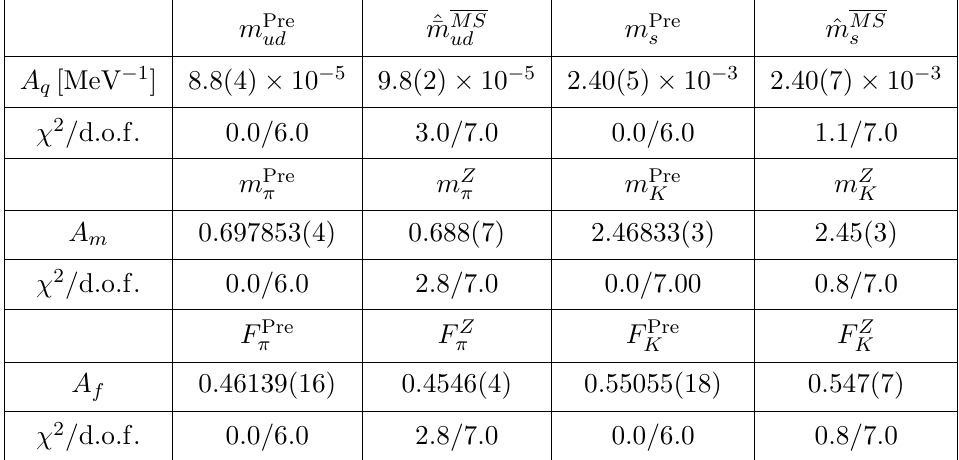
and F Pre (cid:25) K